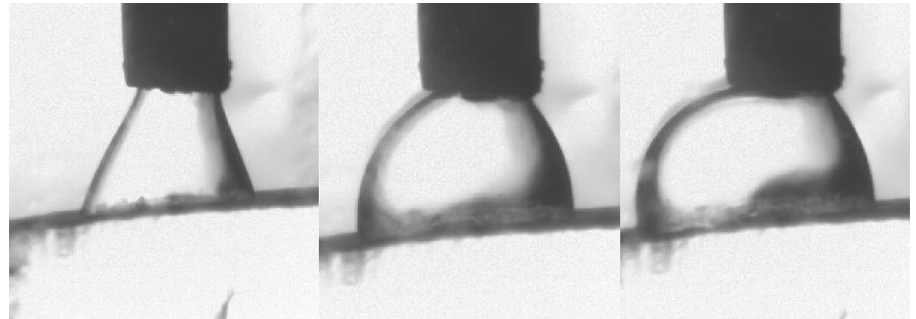
Fig. 6 A sea water drop on a calcite crystal in West Texas crude at different rates of drop deposition at 5.5 MPa and 50 °C